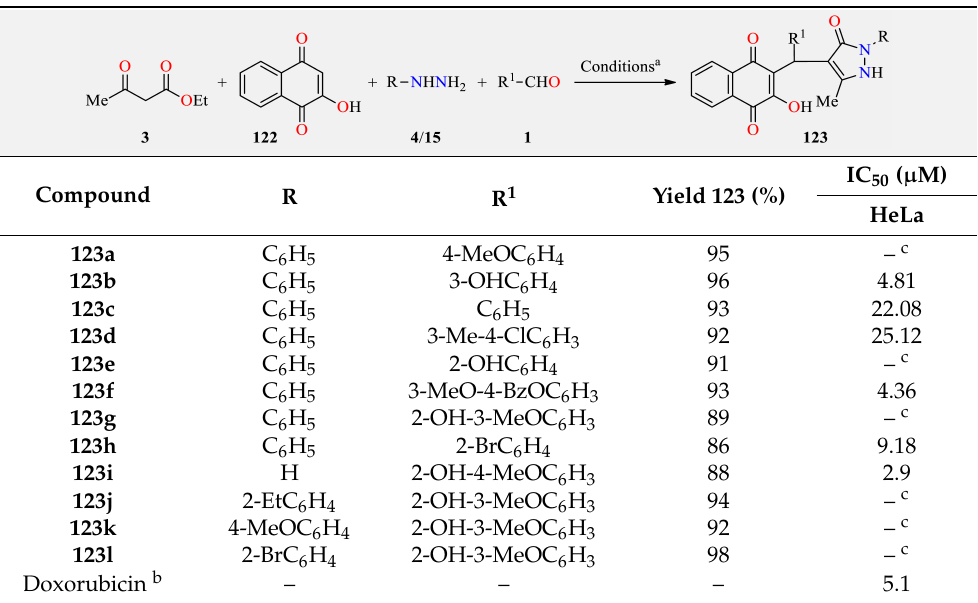
Table 33. Four-component synthesis and anticancer evaluation of pyrazole-based 1,4-naphthoquinones 123 .